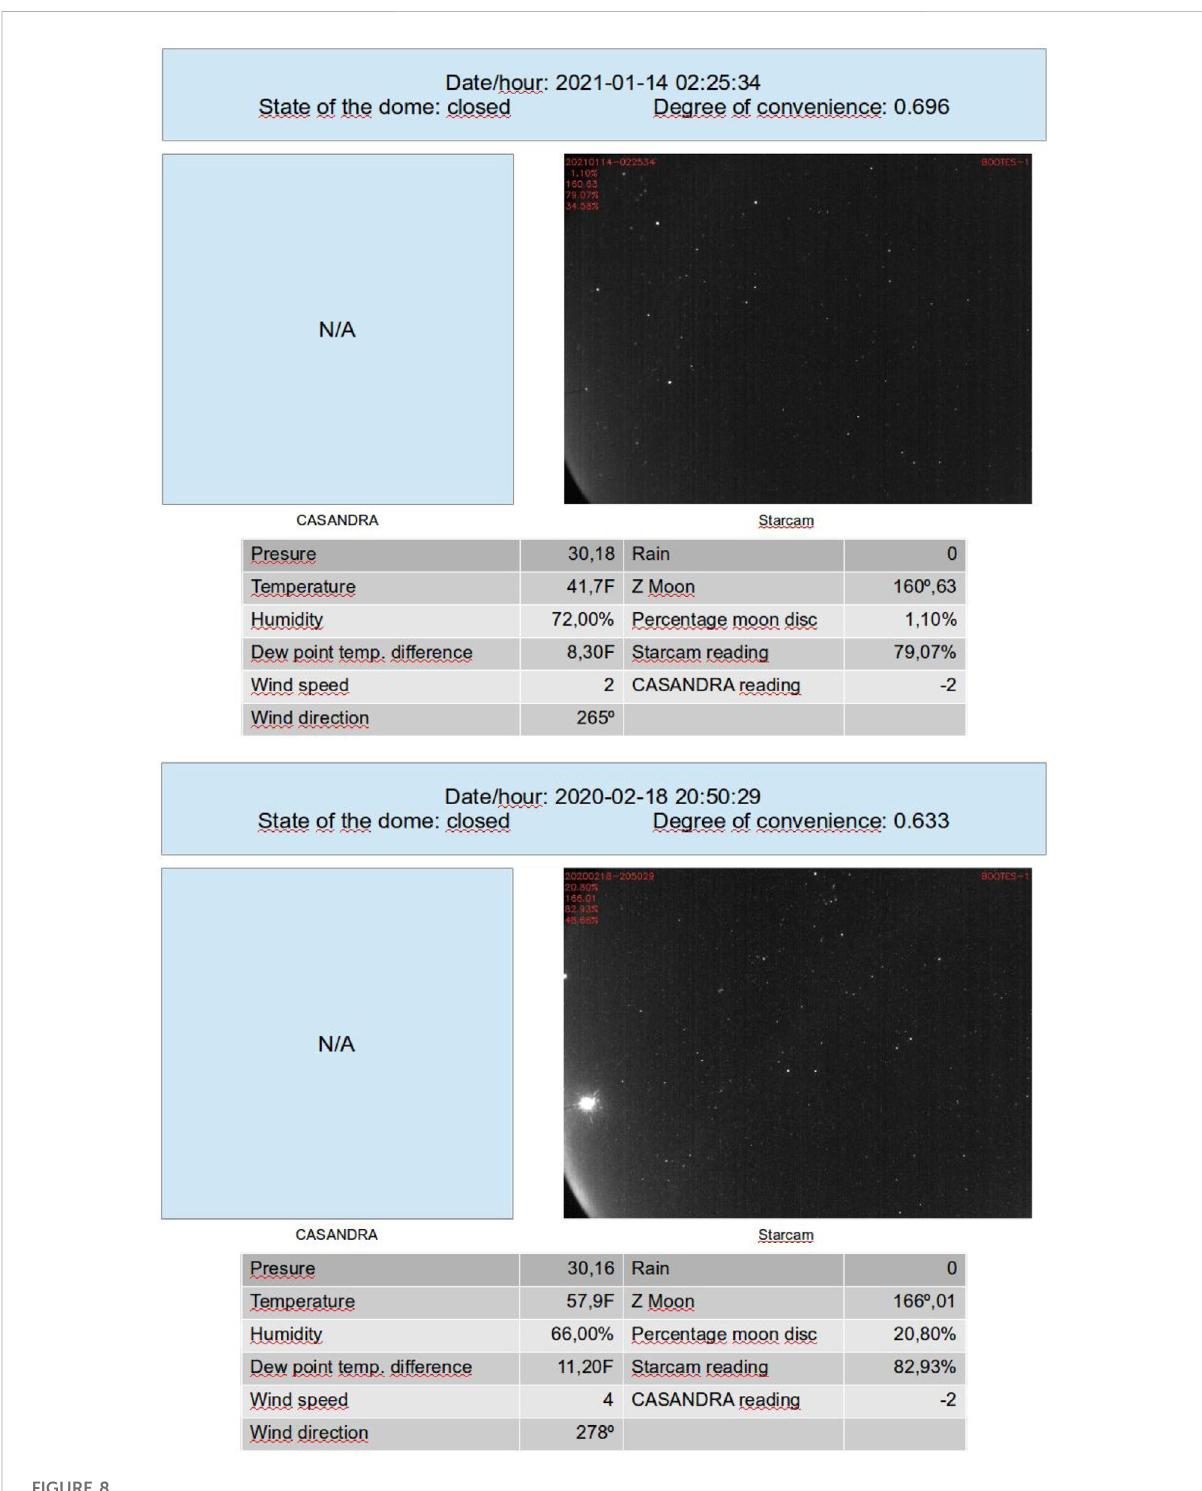
FIGURE 8 Dome was closed, but the degree of convenience indicated that it could have remained